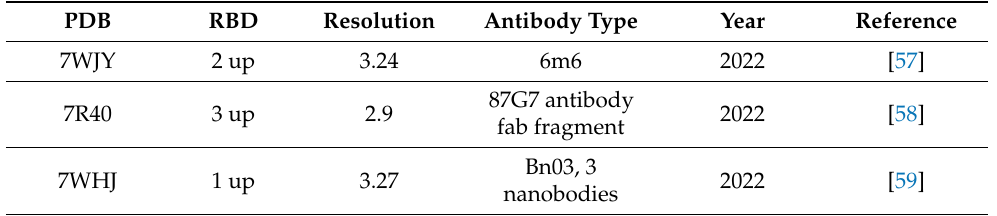
Table 5. Structures of full-length Omicron spike protein complexed with antibodies and